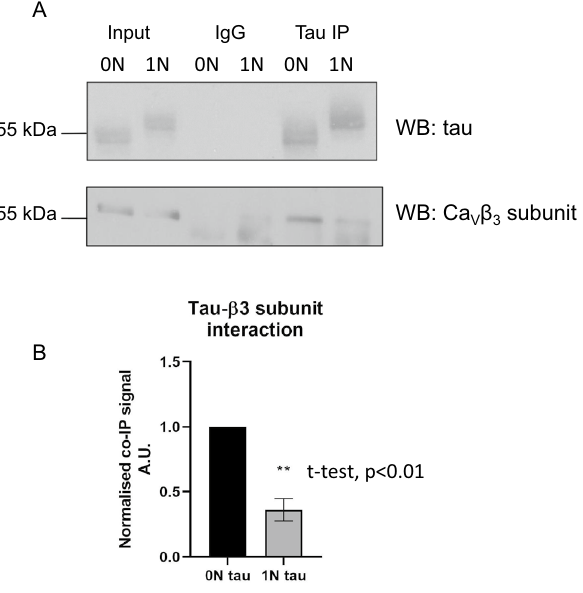
Figure 8. Interaction between tau variants and the Ca V β3 subunit through co-immunoprecipation. Lysates from tsA-201 cells expressing the Ca V β3 subunit together with either 4R0N- or 4R1N-tau were incubated for 1.5 h with either tau antibody or control IgG. Protein G sepharose beads were then added to precipitate the antibody:protein complex and bound proteins were analysed by Western blotting. ( A ) Western blotting with anti-tau antibody confirmed comparable variant expression and specific immunoprecipitation. Western blotting with anti-Ca V β3 showed that the 4R0N tau variant is more strongly associated with the Ca V β3 subunit when compared with 4R1N-tau. ( B ) The ratio of IP tau:Input tau for both 4R0N- and 4R1N-tau, and that for IP Ca V β3:Input Ca V β3 were calculated, followed by the calculation of the CaVβ3/tau ratio, with data presented normalised to the 4R0N-tau label intensity. Data quantification confirmed that there is a statistically significant difference between β3 association with the two tau variants (n = 3, t test, ** p <